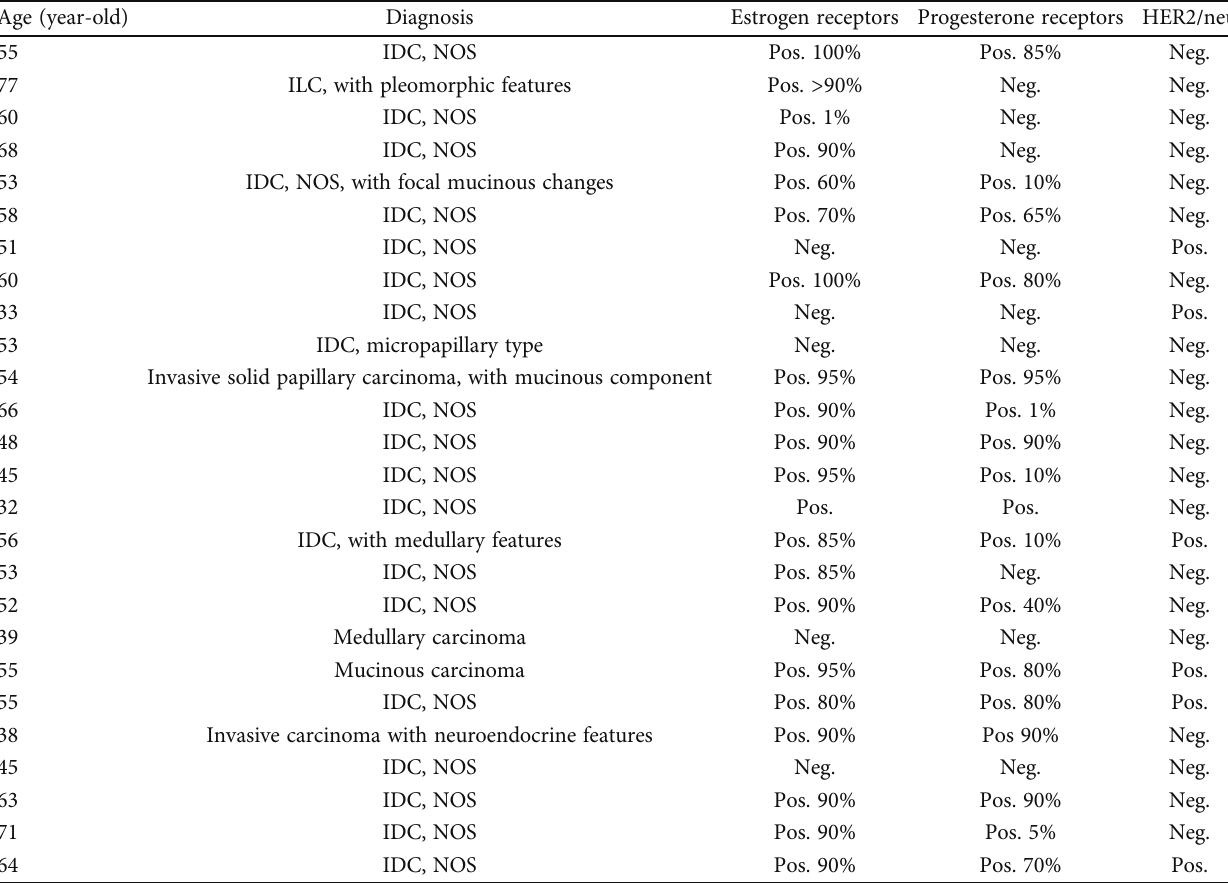
Table 1: Histopathological and immunohistochemistry characteristics of breast cancer cases. Abbreviations: IDC: invasive ductal carcinoma; NOS: not otherwise speci fi ed; ILC: invasive lobular carcinoma; HER2/neu: human epidermal growth factor receptor